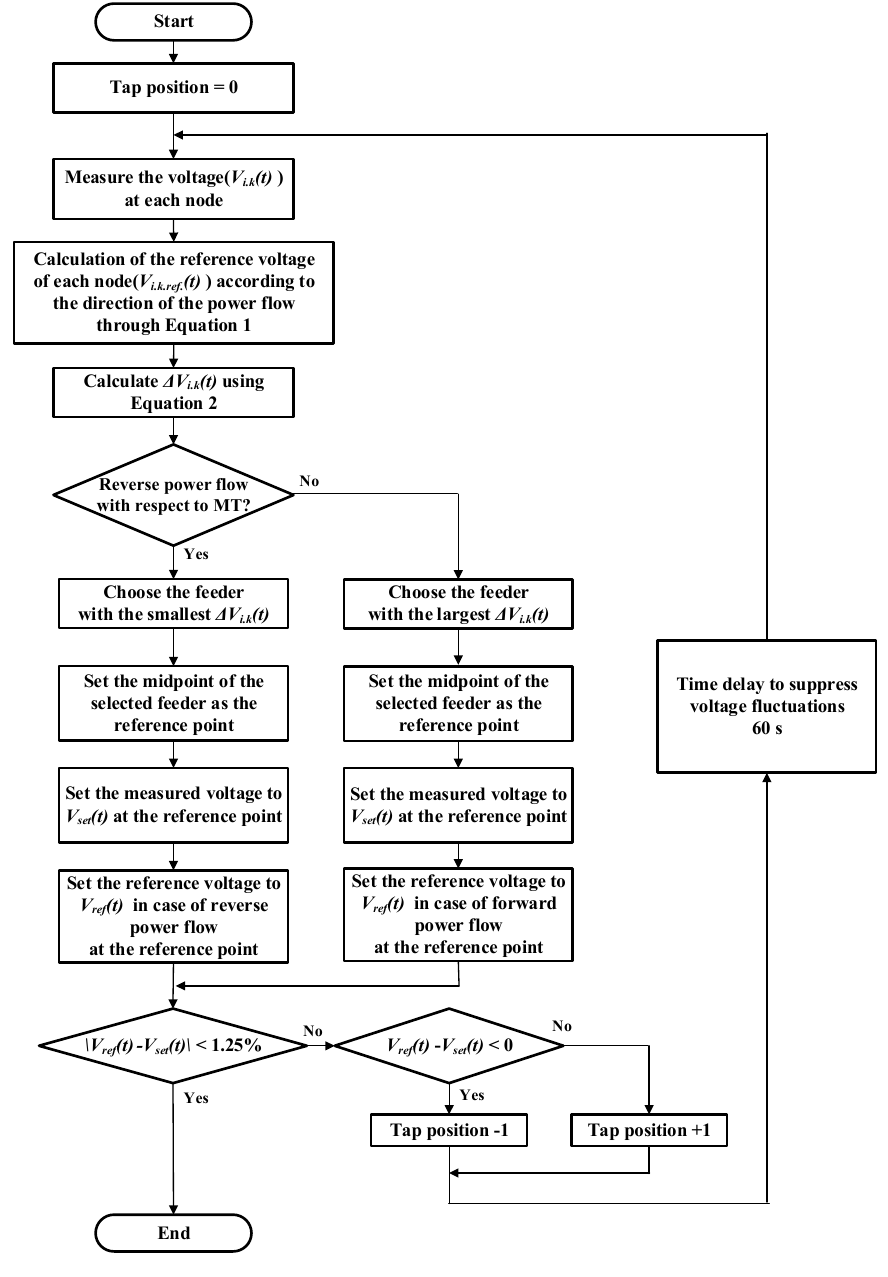
Figure 5. Flowchart of the proposed method.